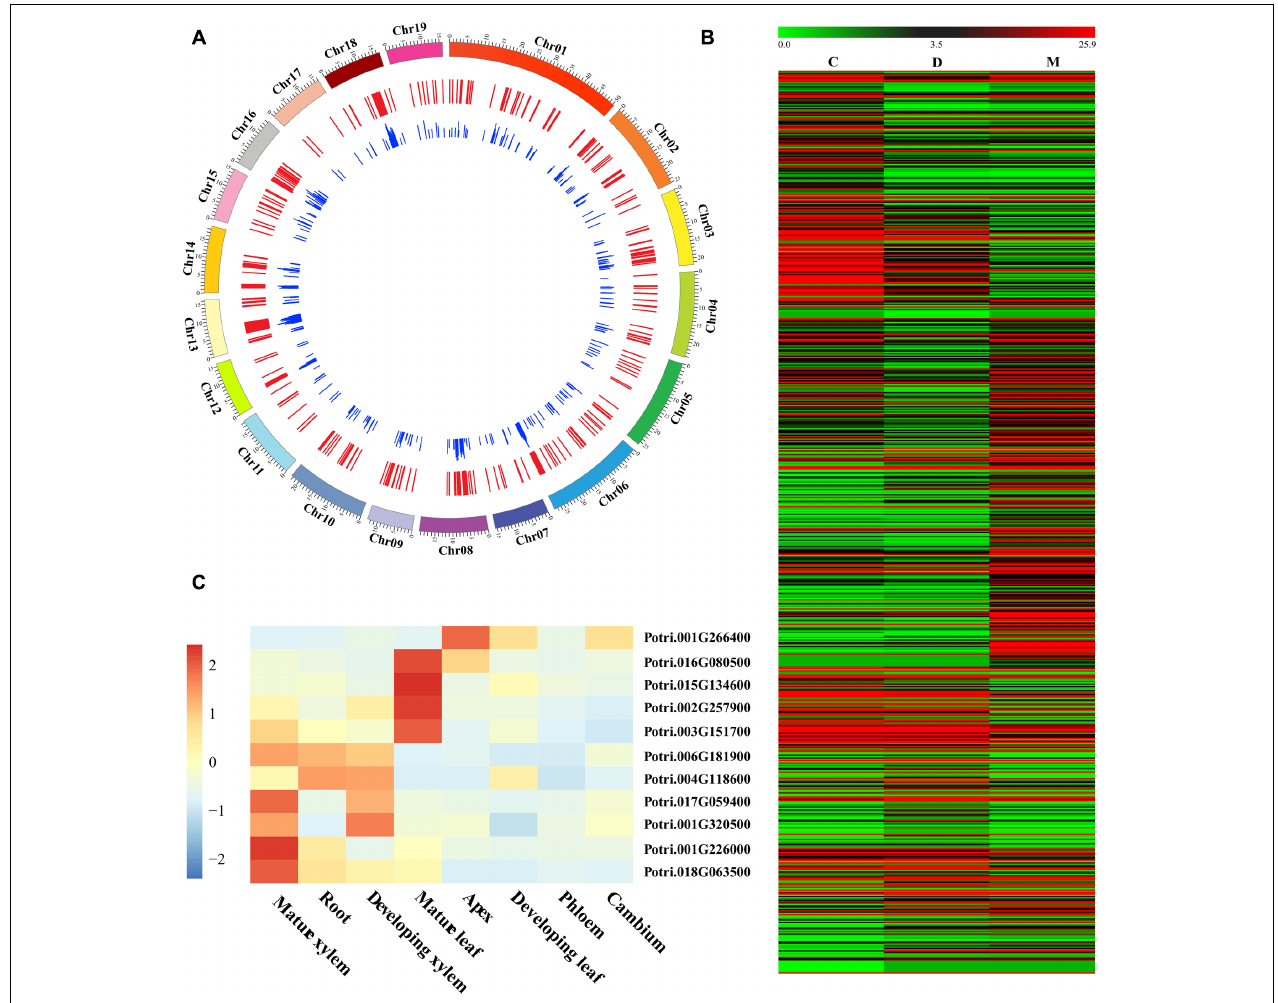
FIGURE 1 | Identification and characterization of differentially expressed (DE) genes in wood tissues of Populus tomentosa. (A) Circular diagram depicting the genomic distribution of the DE genes. The P. tomentosa chromosomes (outer tract), 697 DE genes (middle track), and the frequency of InDels within each gene (inner track) were shown. (B) Heat map of transcriptome data for the DE genes in cambium (C), developing xylem (D), and mature xylem (M) tissues. The color scale is shown at the top. (C) Relative transcript levels of 10 randomly selected DE genes in different tissues and organs of P. tomentosa by RT-qPCR. Expression levels were normalized to the Actin